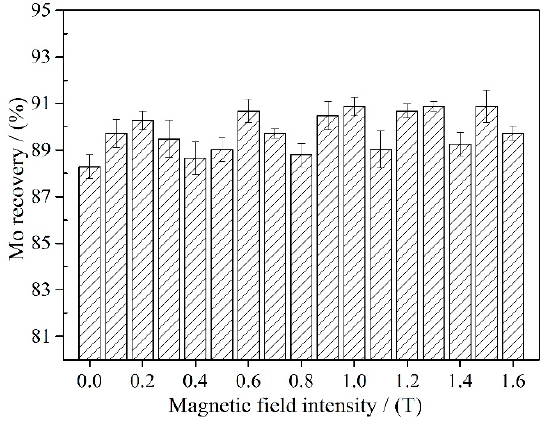
Figure 5. Molybdenum recovery of kerosene with different magnetization intensities (278 K).